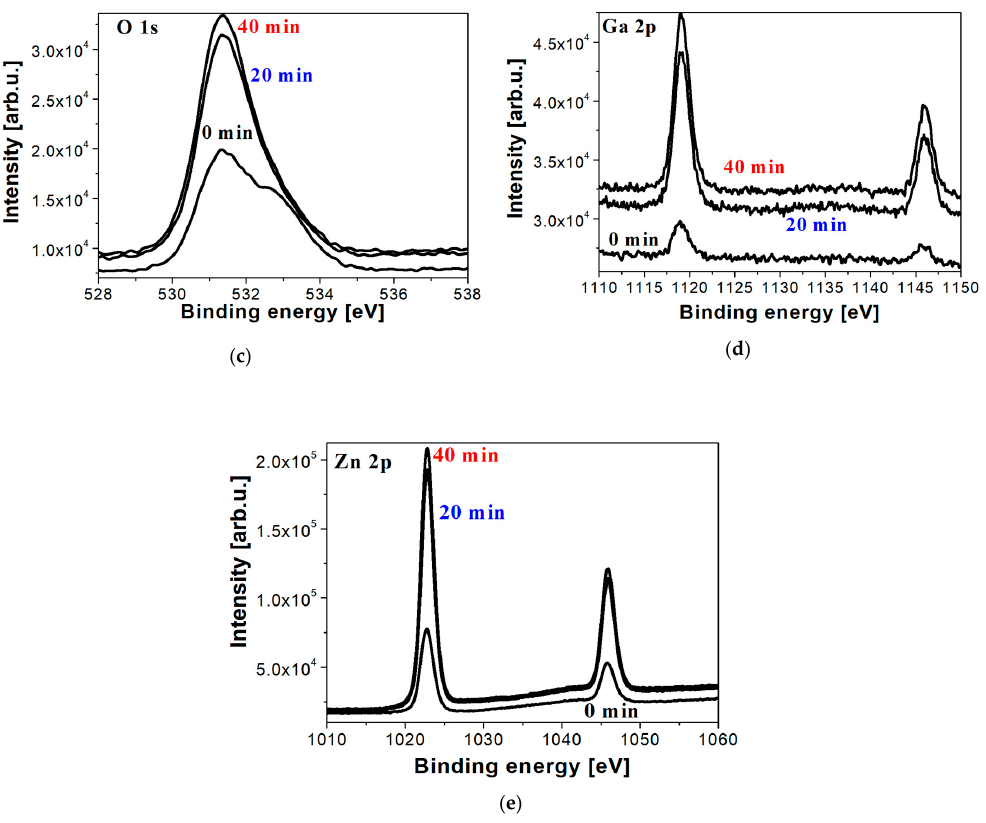
Figure 4. XPS study of ZGO film sputtered at 1.1 kV, performed on the film before and after Ar + etching for 20 and 40 min, where ( a ) presents XPS wide survey spectra and ( b–e ) show XPS spectra in C1s, O1s, Ga2p and Zn 2p regions of ZGO film, respectively.